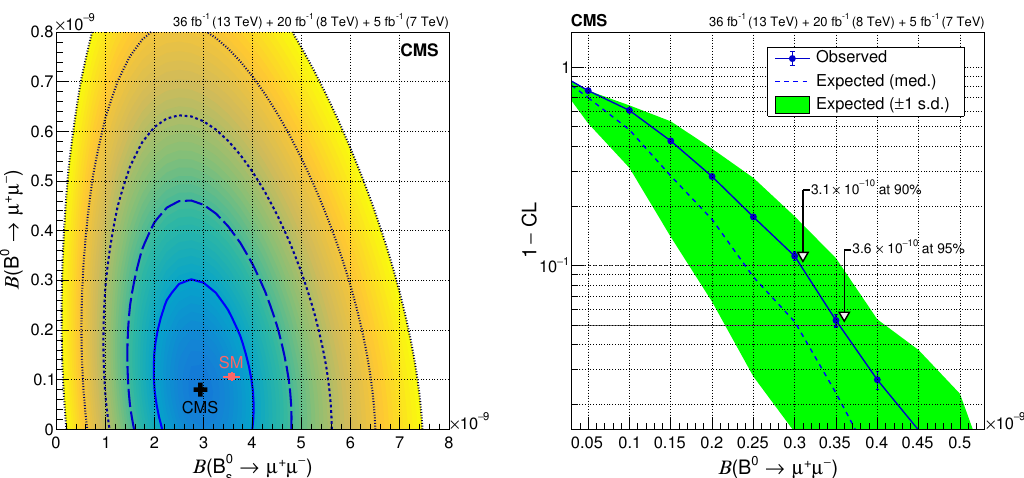
Figure 6 . (Left) Likelihood contours for the (cid:12)t to the branching fractions B (B 0 B (B 0 ! (cid:22) + (cid:22) (cid:0) ), together with the best-(cid:12)t value (cross) and the SM expectation (solid square). The contours correspond to regions with 1{5 standard deviation coverage. (Right) The quantity 1 (cid:0) CL as a function of the assumed B 0 ! (cid:22) + (cid:22) (cid:0) branching fraction. The dashed curve shows the median expected value for the background-only hypothesis, while the solid line is the observed value. The shaded region indicates the (cid:6) 1 standard deviation uncertainty